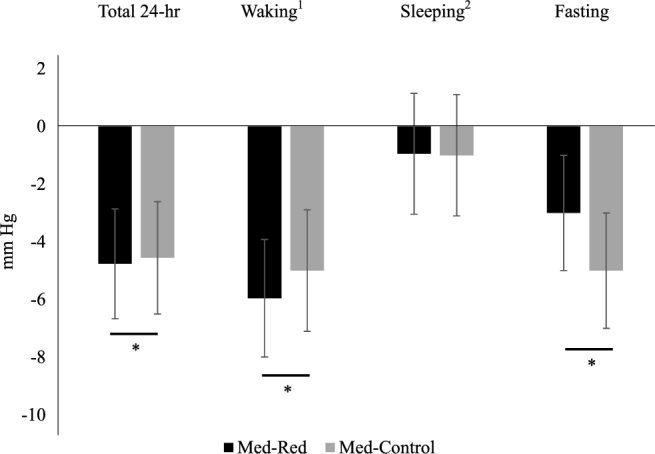
Changes in systolic blood pressures from consuming a Med-Red or Med-Control diet for 5 wk. Results are presented as LS means ± SEMs (n = 41). Data were analyzed using a doubly repeated-measures ANOVA adjusted for age, sex, and body mass at each time point. *Change over time. 1Waking blood pressure: 0800–2100. 2Sleeping blood pressure: 2230–0730. Diastolic blood pressure results followed similar patterns and are available in Supplemental Tables 1 and 2. LS, least squares; Med-Control, Mediterranean-style eating pattern with ∼200 g lean, unprocessed red meat/wk; Med-Red, Mediterranean-style eating pattern with ∼500 g lean, unprocessed red meat/wk.